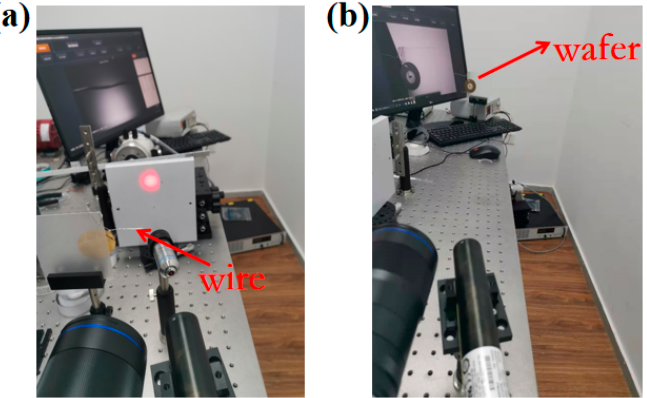
Figure 16. Physical diagram of focal plane determination in ( a ) the first two experiments and ( b ) the last two experiments.